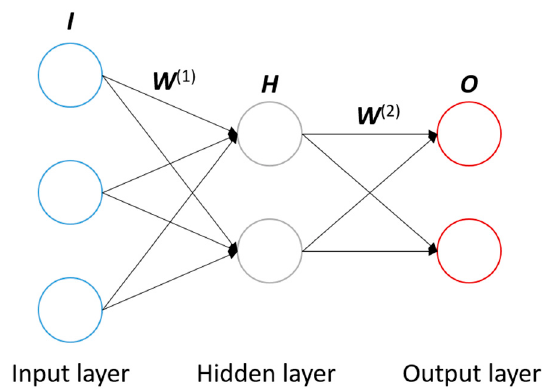
Figure 2. Diagram of the NN topography.